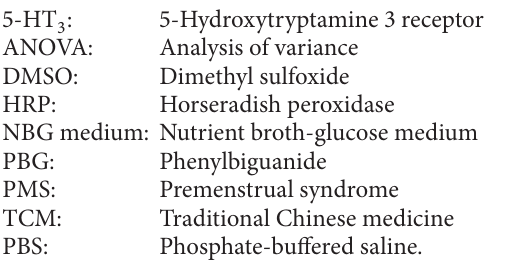
decreased; moreover, the channel current was also